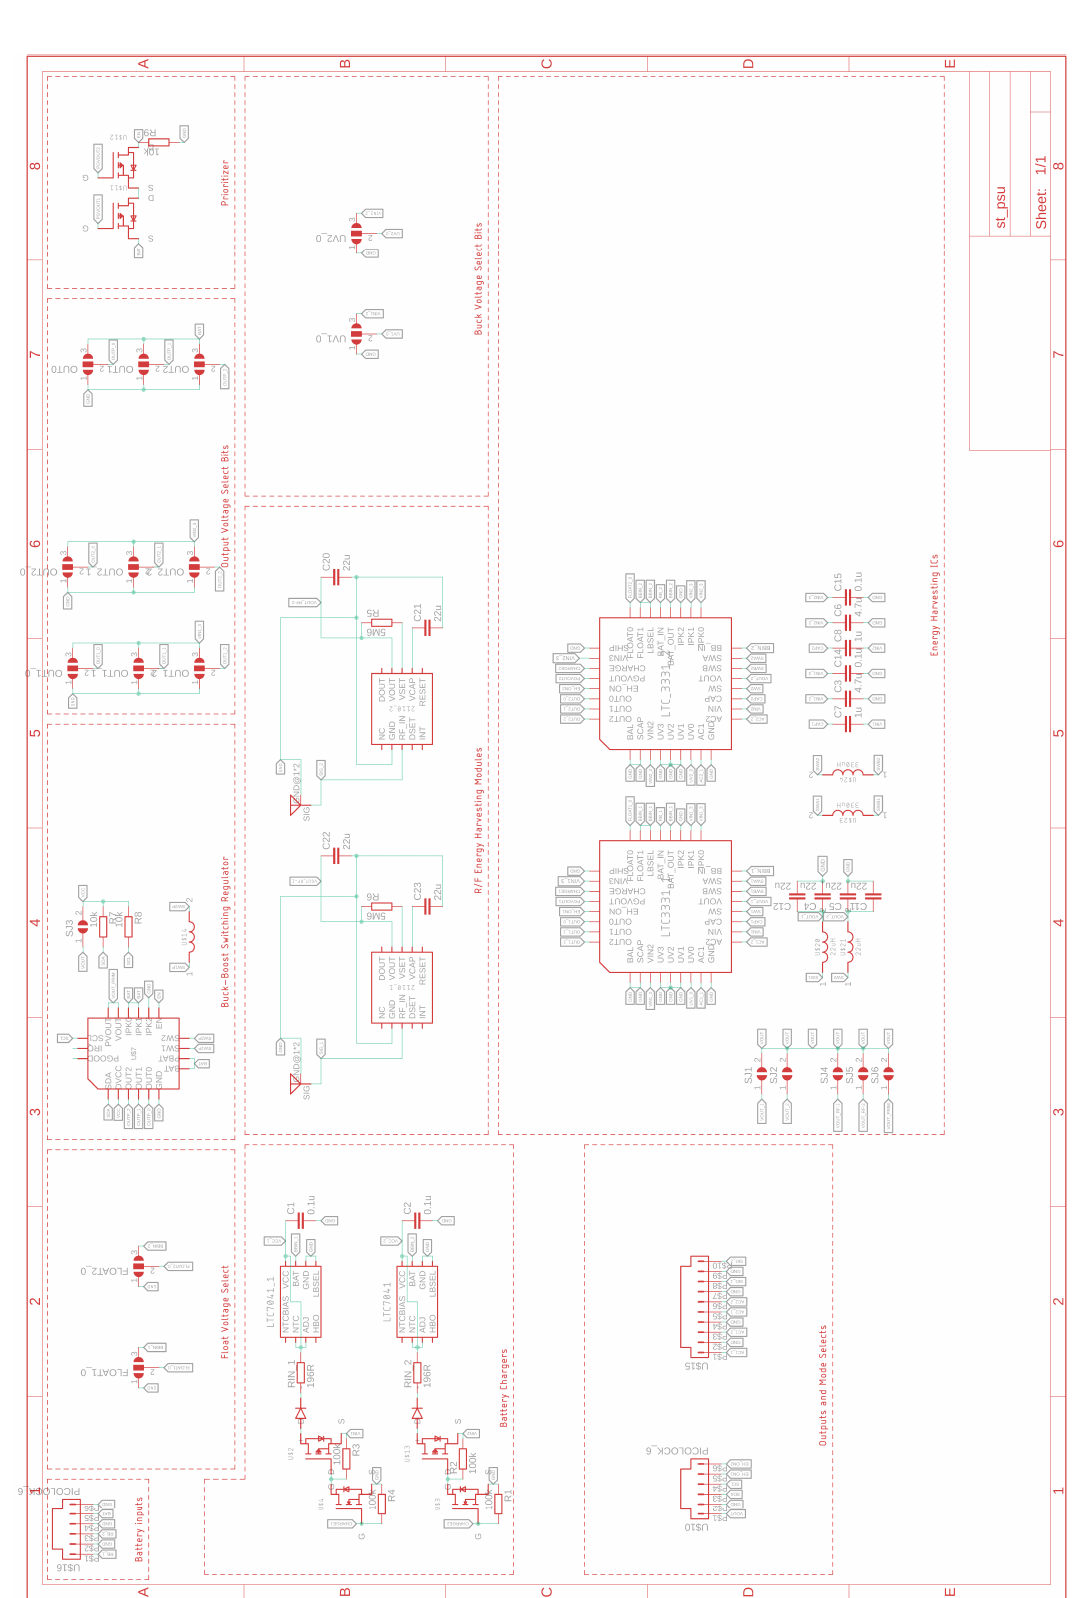
Figure 16. Detailed schematic of the proposed energy management